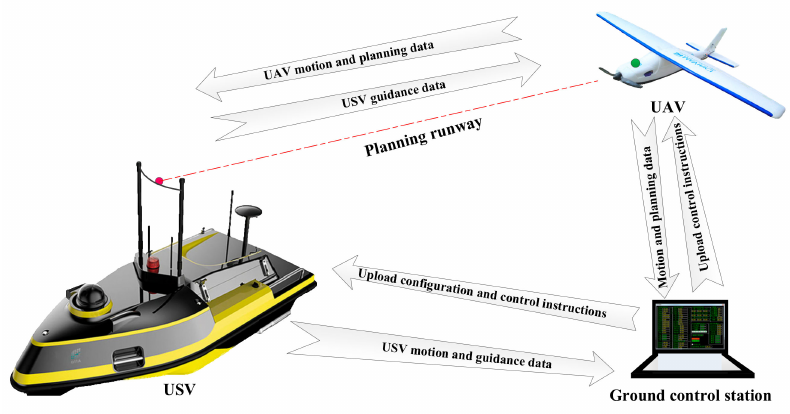
Figure 5. Relative pose measurement